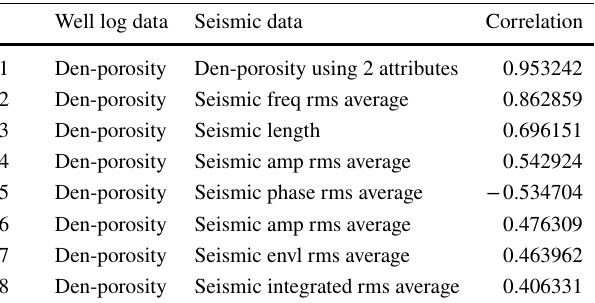
Table 12 Verification of correlation attributes by adding multi-attrib-